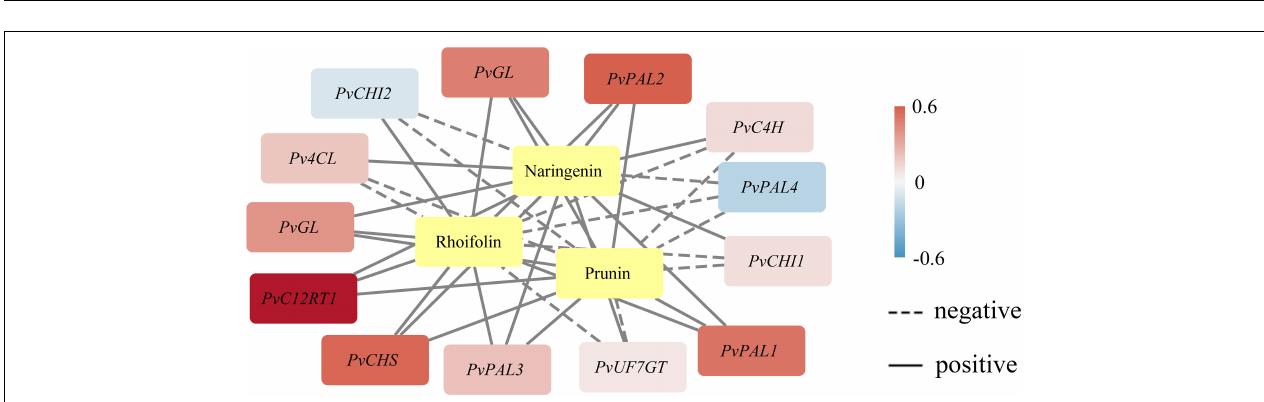
FIGURE 2 | The key genes and metabolites related to the flavonoid pathway. A branch of the flavonoid biosynthesis pathway (A) with relative expression of key genes (B) and contents of metabolites (C) . The red color indicates the differentially expressed genes, and the yellow box indicates the involved flavonoids. Metabolic pathway adapted from Ishihara et al. (2015) and amendments involved displaying the newly identified genes and metabolites under this study and the Kyoto Encyclopedia of Genes and Genomes (KEGG) portal used for analysis.